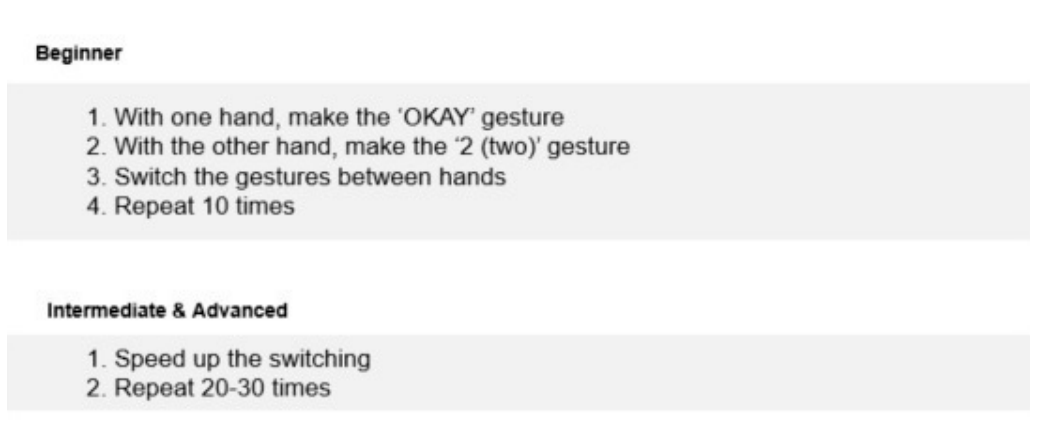
Figure A25. Detailed description and components of each movement in the “Okay 2” finger-and-toe